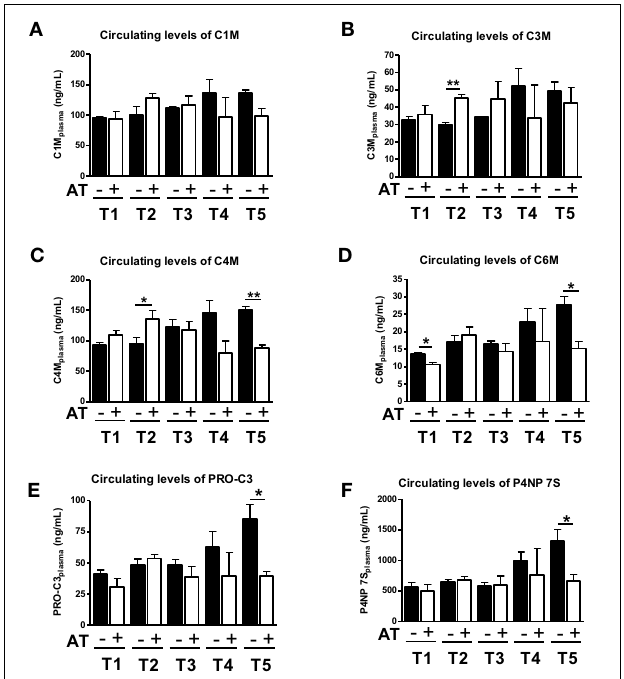
FIGURE 3 | Levels of ECM markers in blood with ( + AT) or without (–AT) atorvastatin treatment. BDL rat liver fibrosis model with atorvastatin intervention 1 (T1), 2 (T2), 3 (T3) and 5 (T5) weeks post BDL surgery. Plasma levels of C1M, C3M, C4M, C6M, PRO-C3, and P4NP 7S levels are shown as mean levels ± standard errors for all time points. Asterisks indicate statistical significance as indicated by bars. ( ∗ p < 0 . 05, ∗∗ p < 0 . 01).